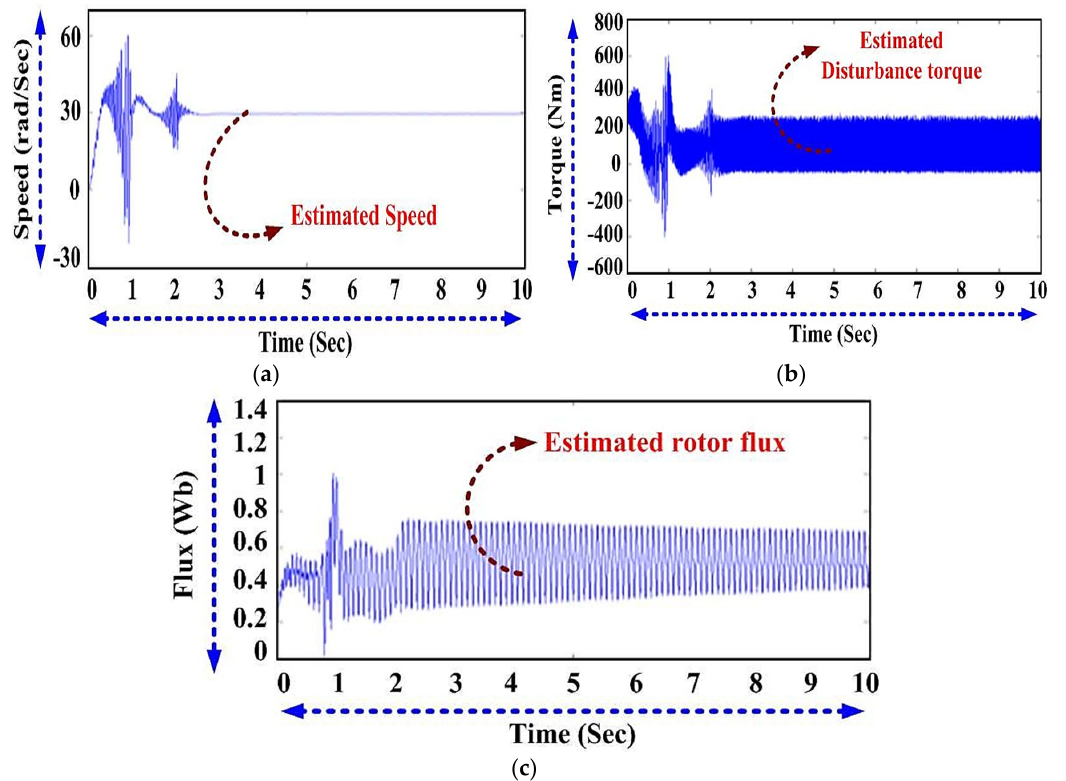
Figure 12. SMLO2: ( a ) estimated speed, ( b ) estimated torque and ( c ) estimated rotor flux.